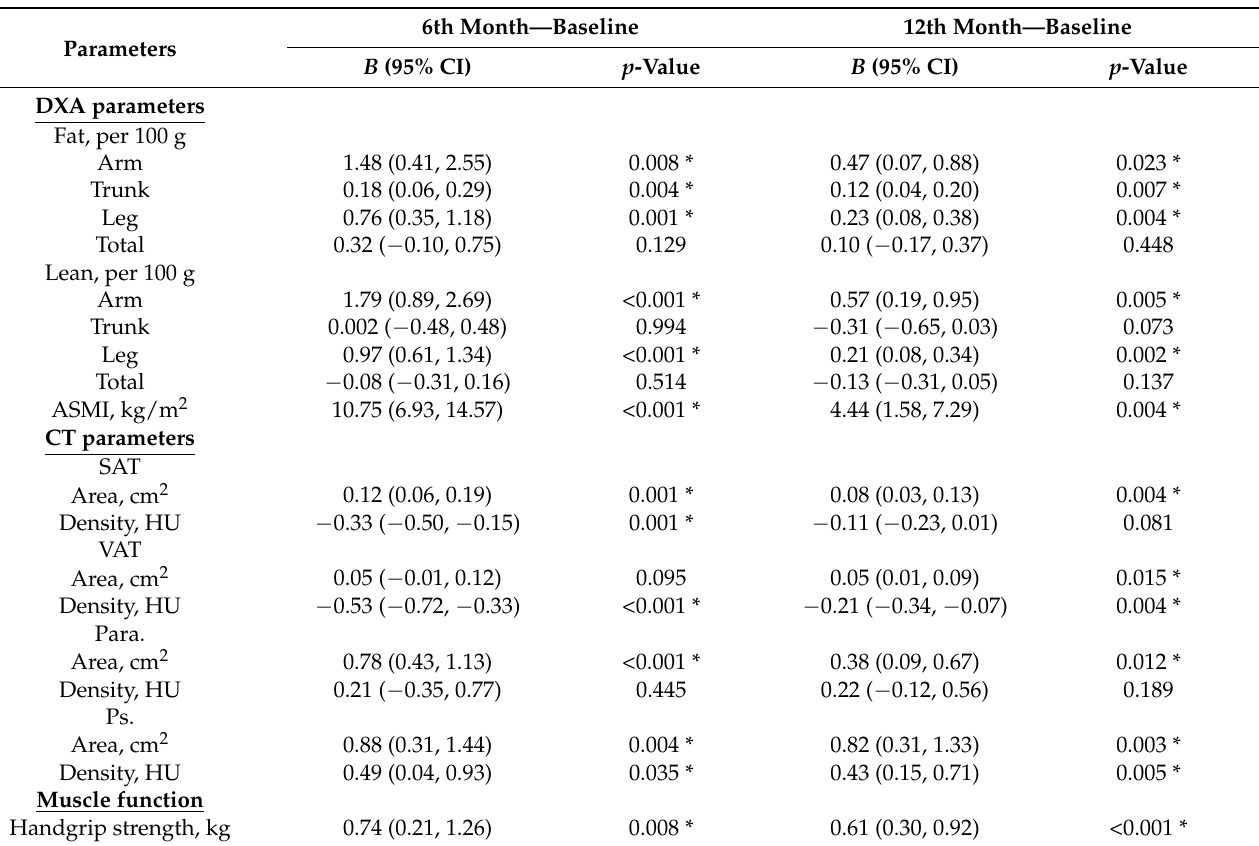
Table 5. The association between change of body composition and change of prognostic nutrition index in the exercise group.